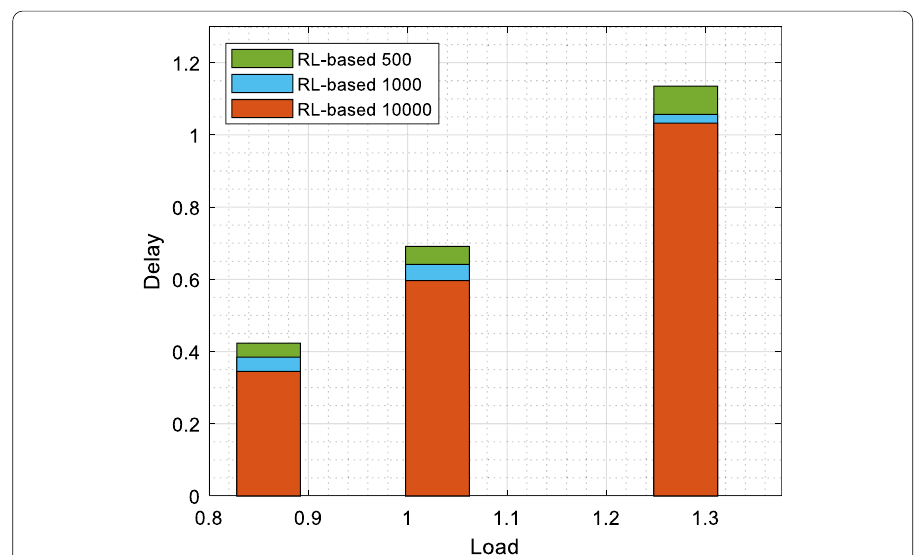
Fig. 9 The impact of the number of iterations on delay optimization. The effect of the number of iterations on the delay optimization with the data when the load is 0.86, 1.03, and 1.28. The three colors indicate 500 iterations, 1000 iterations, and 10,000 iterations, respectively. The x -axis is the loads, and the y -axis is the average delay